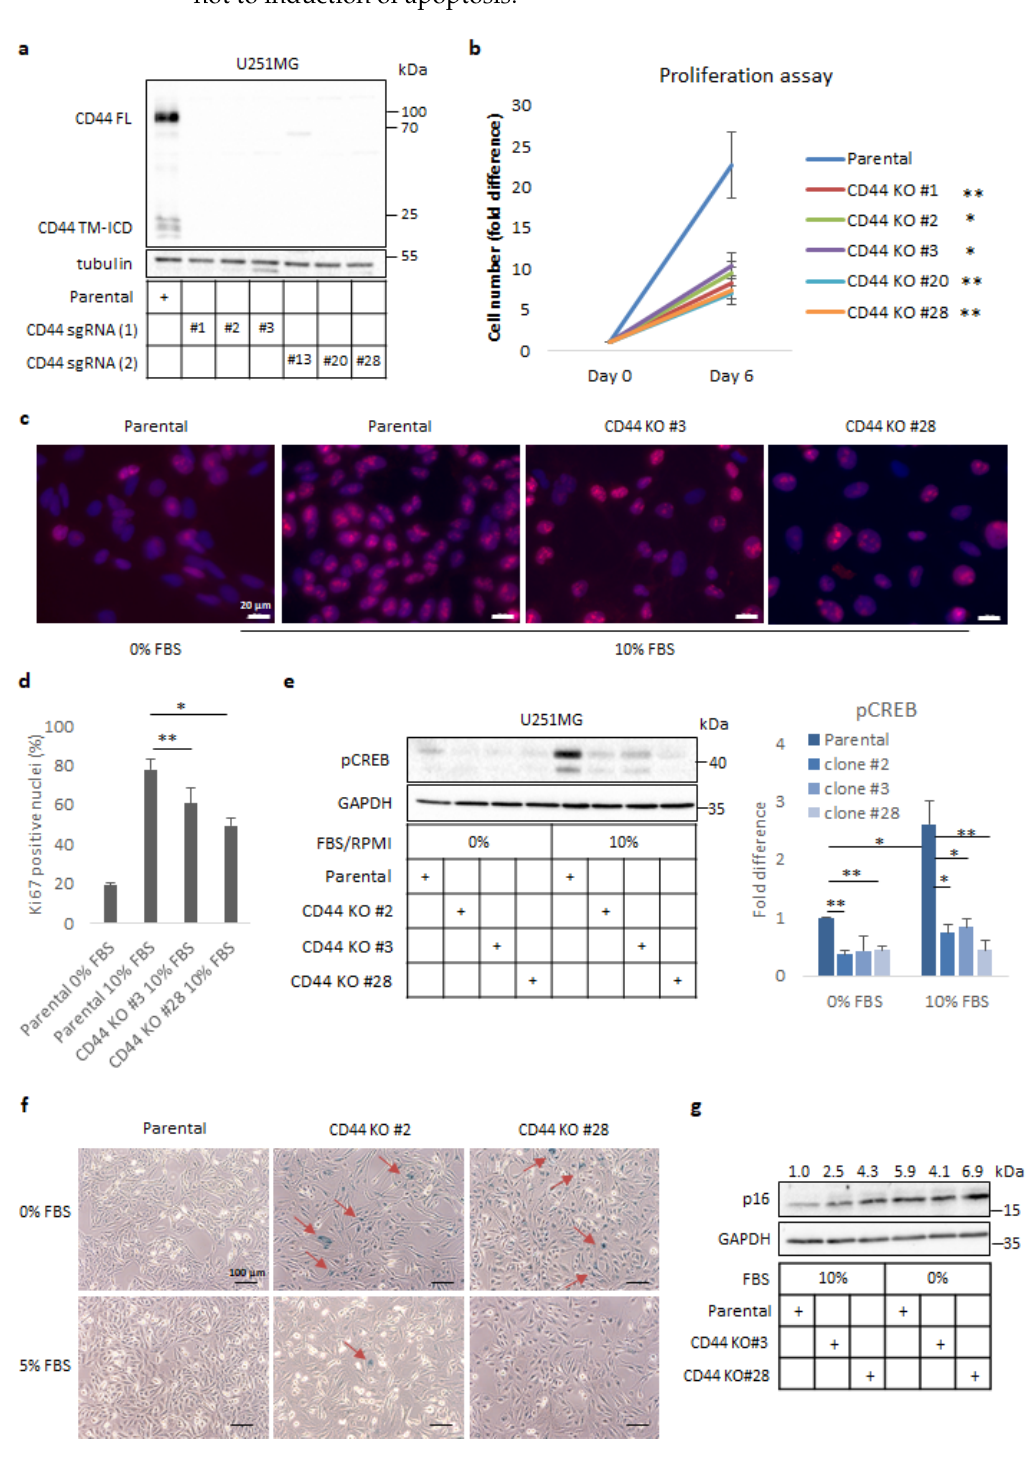
Figure 1. CD44 depletion reduces proliferation of U251MG cells and induces cellular senescence. ( a ) Immunoblot analysis of full length (FL) and cleavage products (TM-ICD) of CD44 in either parental